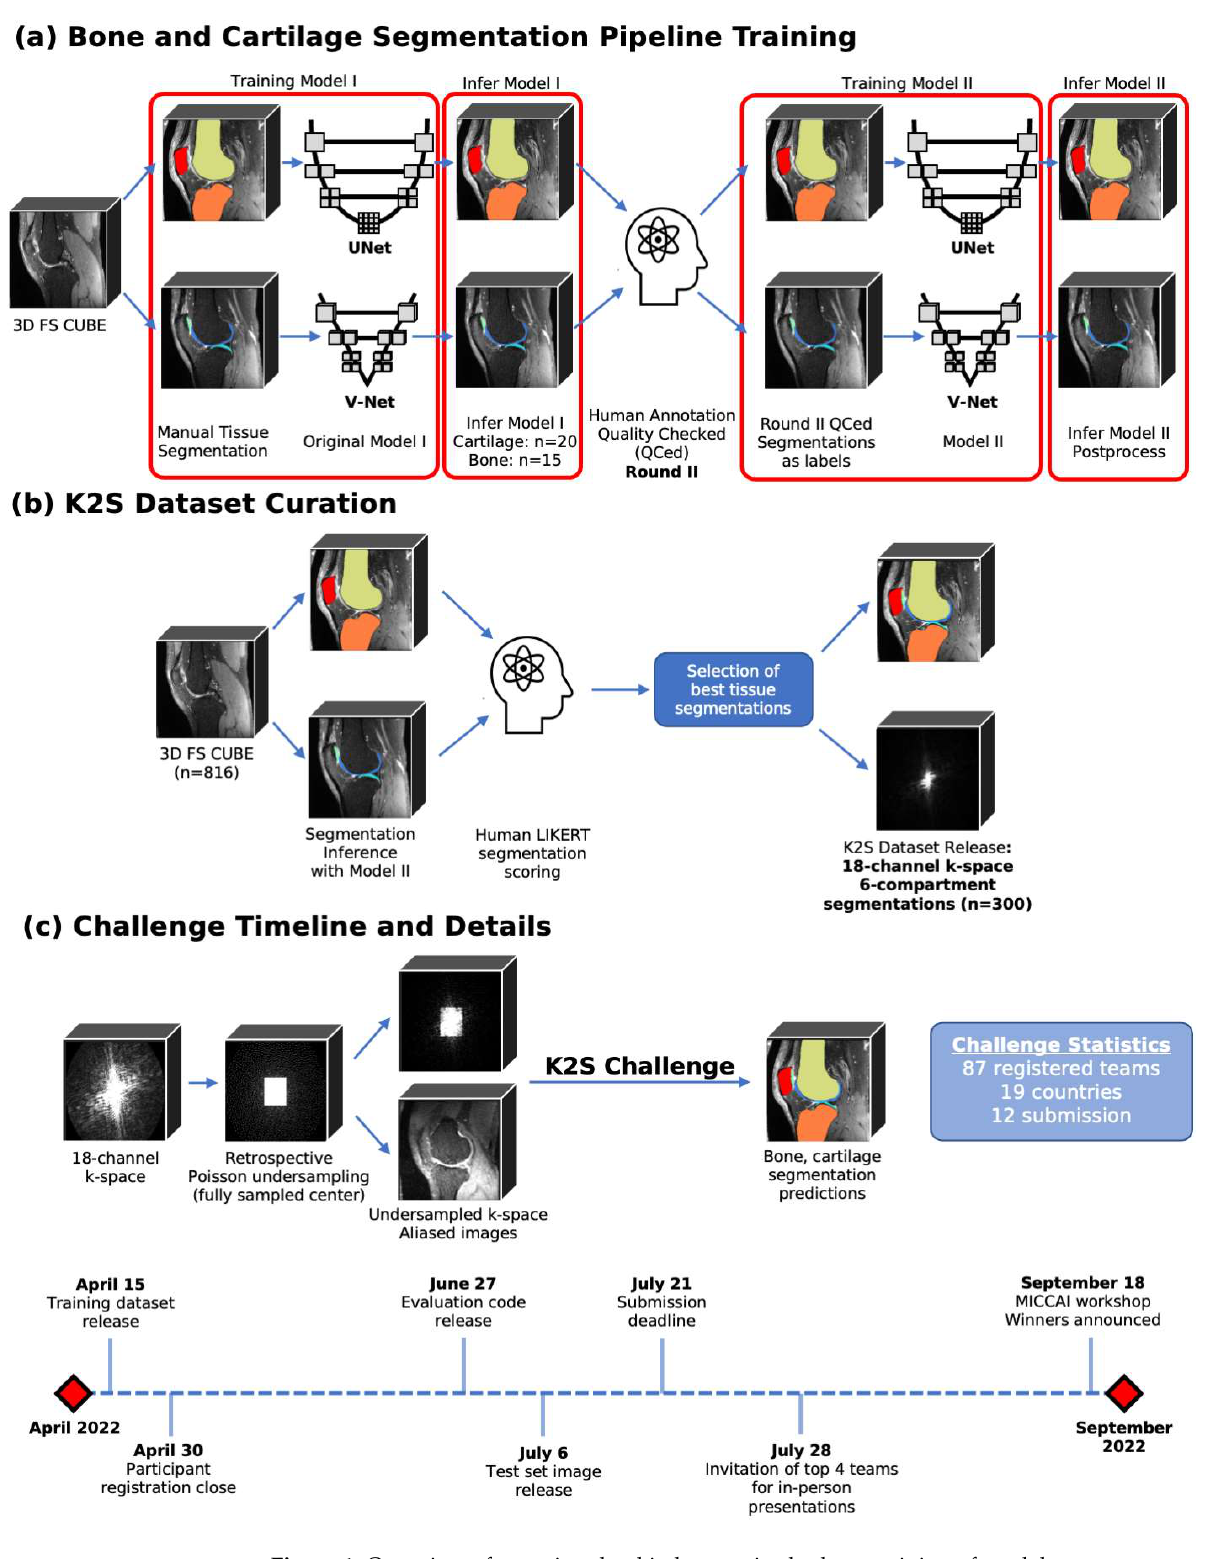
Figure 1. Overview of steps involved in human-in-the-loop training of models to generate ground truth bone and cartilage segmentations, and the process for radiologist approval of final 300 segmentations to be included in K2S dataset. The K2S challenge was for participants to segment knee bones and cartilage from 8× undersampled k-space, with the training set released on 15 April, the test set released on 6 July, and the submission deadline on 21 July.